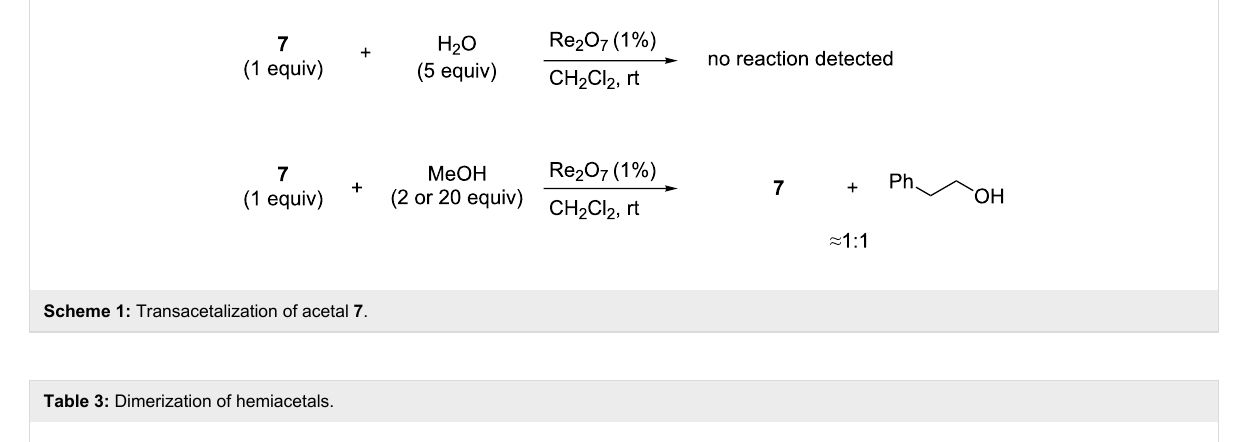
Scheme 1: Transacetalization of acetal 7 .